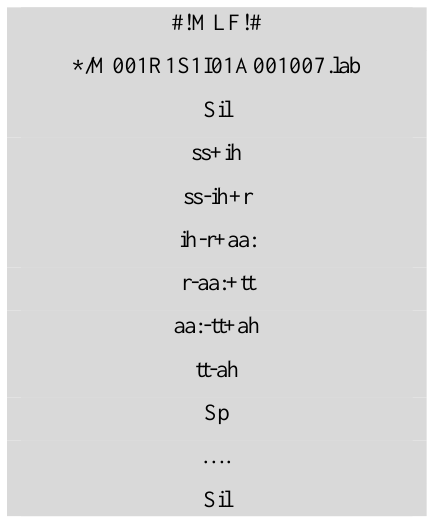
Figure 11. Sample of HTK triphone tree.